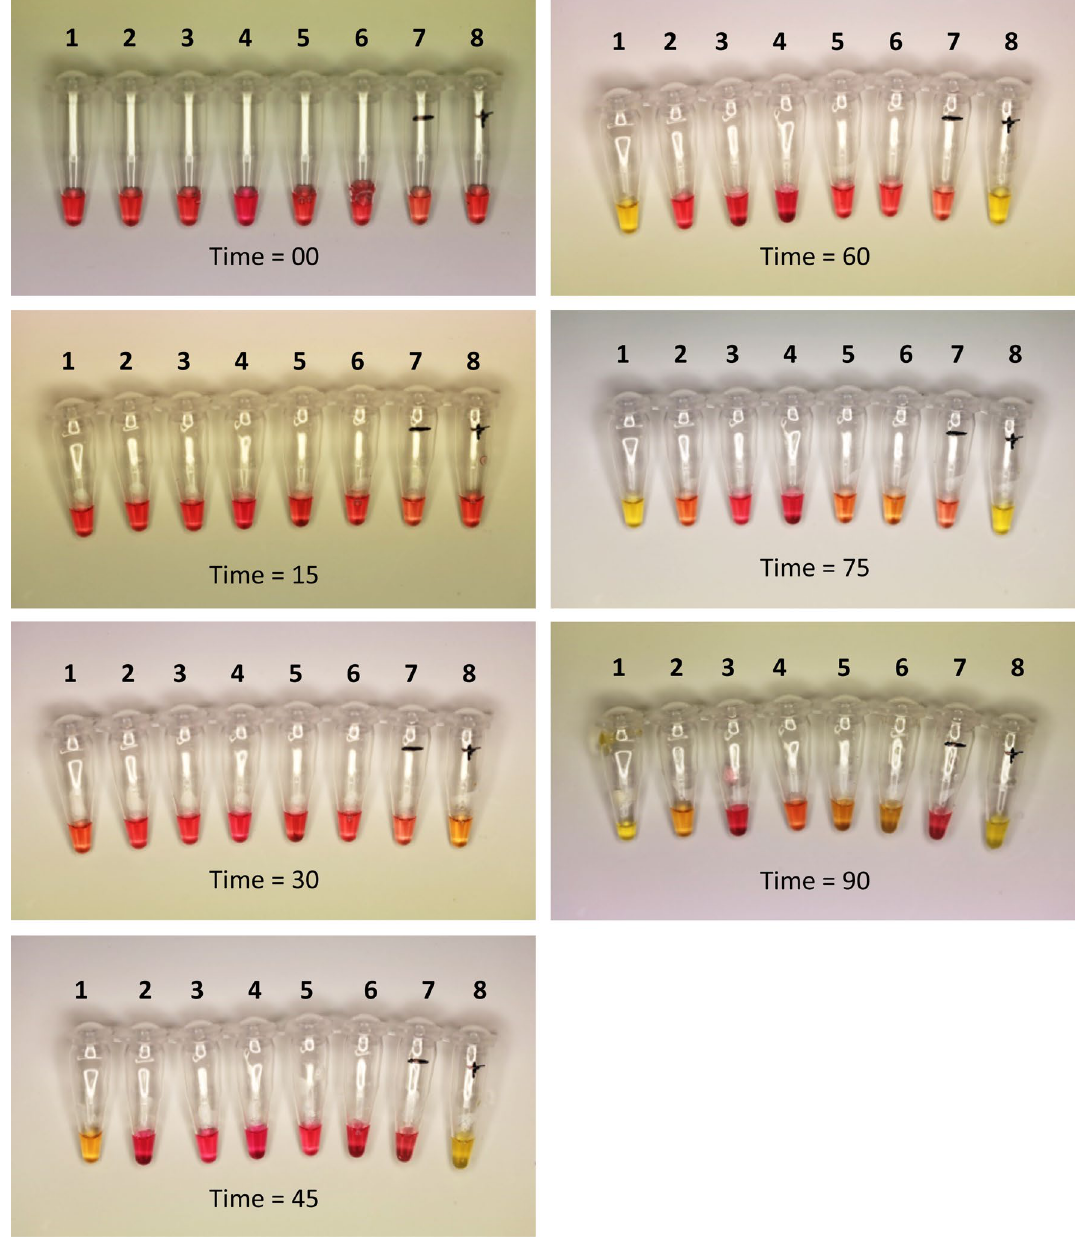
Figure 5. Time-series of FAW LAMP (new assay primers) using colorimetric master mix. Ninety minutes total amplification time shown in increments of 15 min. Samples: (1) Spodoptera frugiperda , (2) Spodoptera litura (PNG), (3) Spodoptera exigua, (4) Helicoverpa armigera conferta, (5) Mythimna convecta, (6) Leucania loreyi, (7) no-template negative control and (8) FAW gBlock DNA dilution 10 6 . The colour change from pink to yellow in tube 1 and 8 indicates positive samples. Negative samples did not change